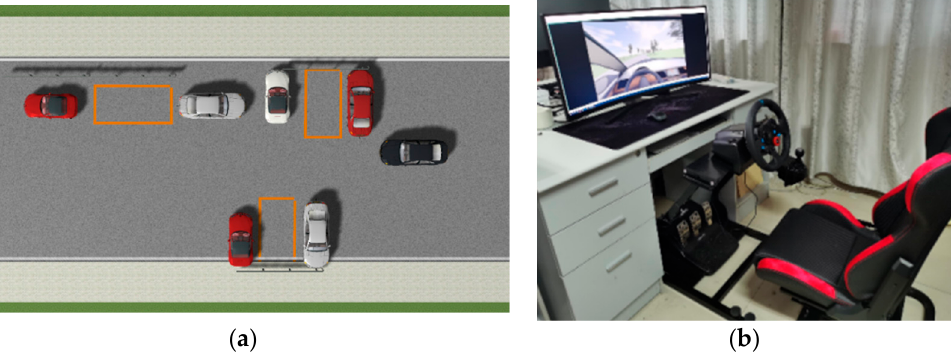
Figure 4. ( a ) Simulated parking environment for capturing intelligent parking driving models. ( b ) Driving simulator.